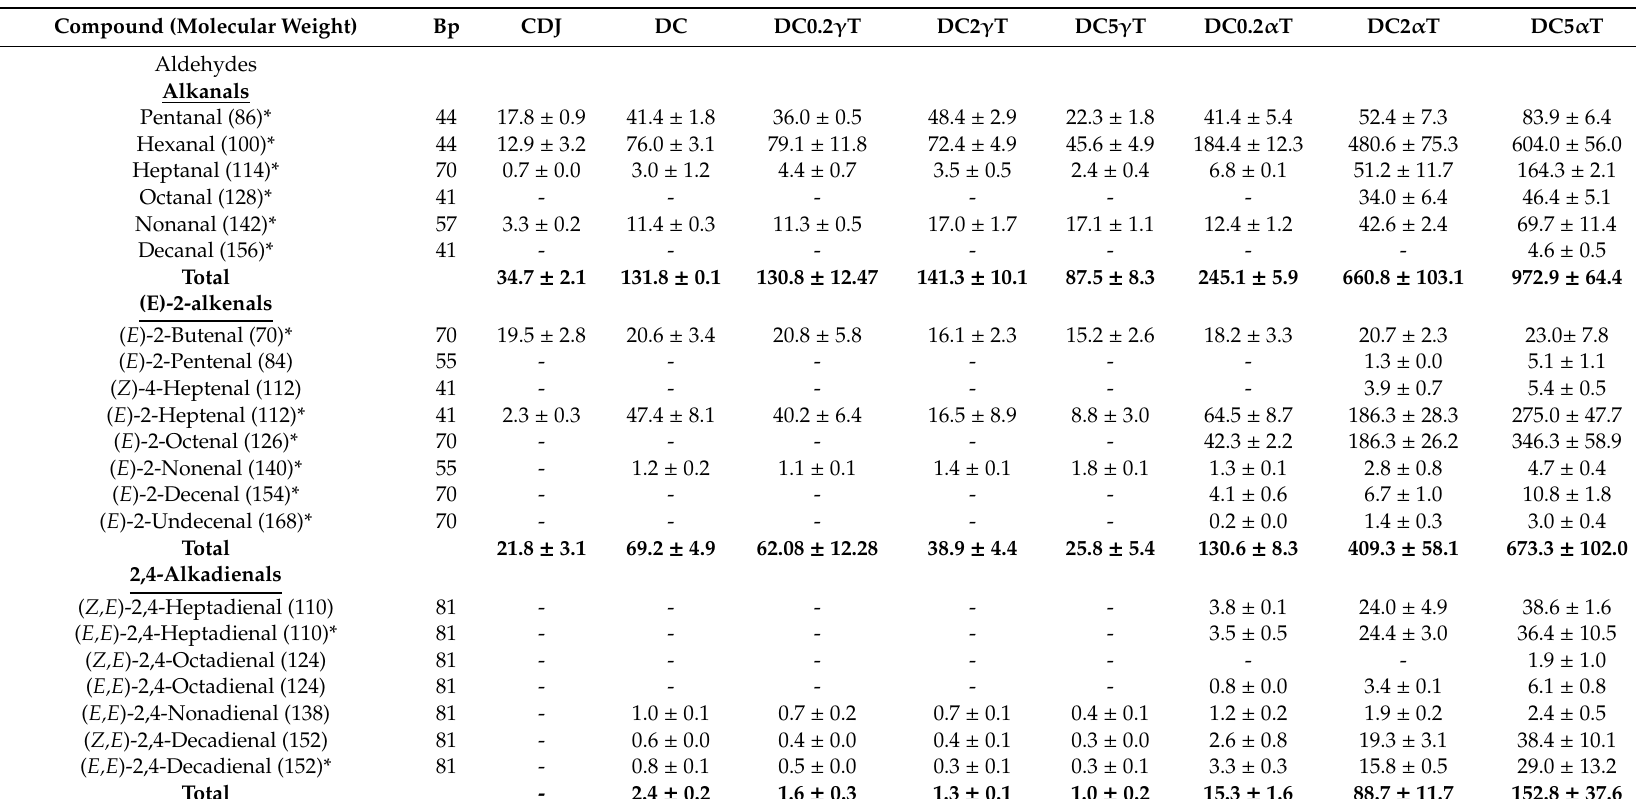
Table 3. Abundances of some aldehydes (alkanals, ( E )-2-alkenals, 2,4-alkadienals and oxygenated alpha,beta unsaturated aldehydes), furanones and furan derivatives identified by SPME-GC / MS, in the headspace of the mixture of digestive juices and non-enriched corn oil sample (CDJ), in the digestates of the corn oil (DC) and in those of oil samples enriched in gamma - and alpha -tocopherol (DC0.2 γ T, DC2 γ T, DC5 γ T DC0.2 α T, DC2 α T and DC5 α T). Data are given in area counts of their mass spectra base peak (Bp) multiplied by 10 -6 , and obtained as an average of two determinations, together with their standard